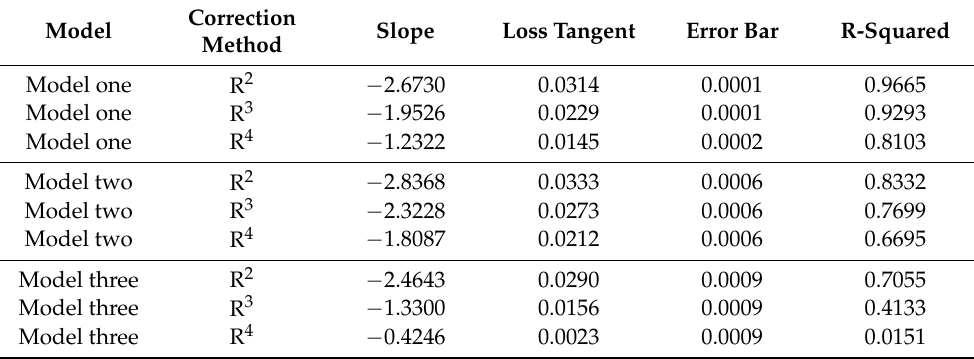
Table 1. The attenuation’s estimated result of three